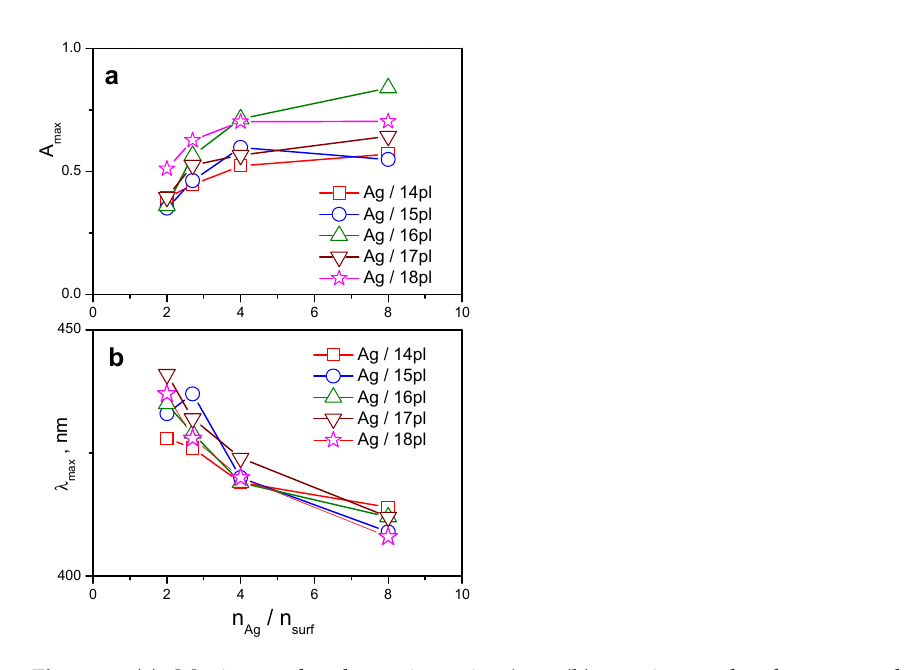
Figure 2. ( a ): Maximum absorbance intensity A max ( b ): maximum absorbance wavelength λ max plotted as a function of n Ag /n surf .